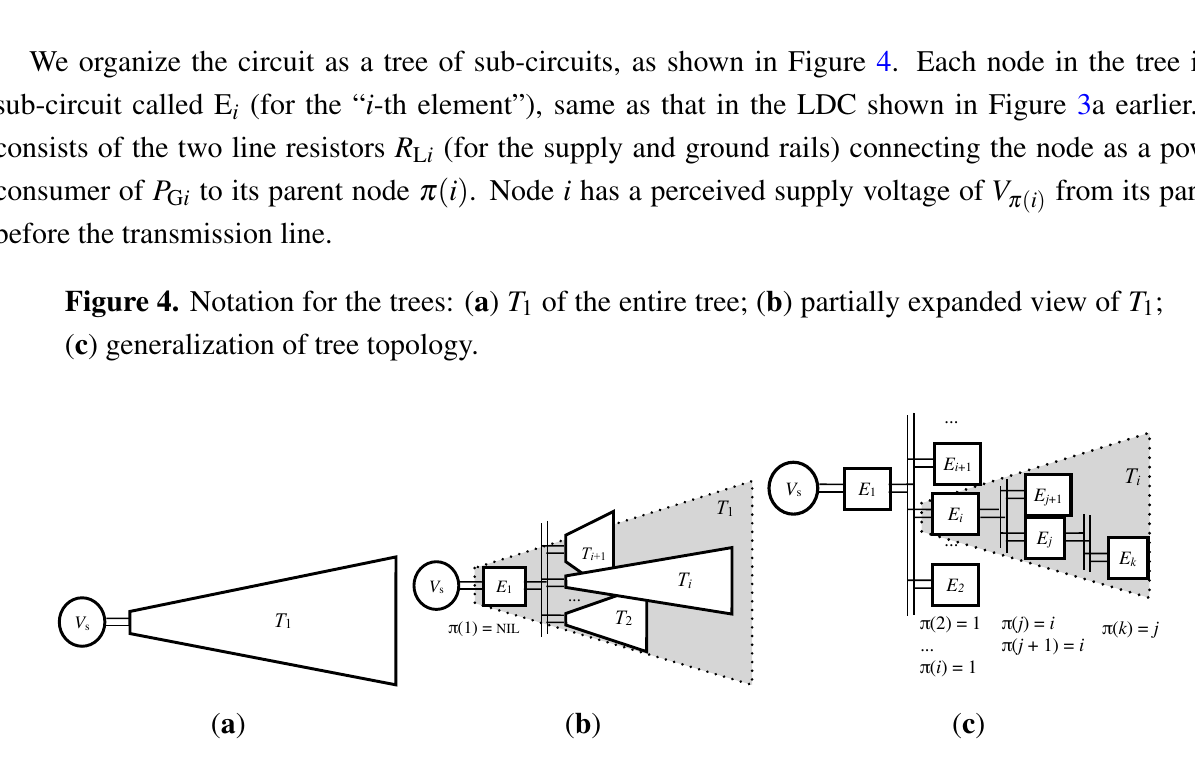
of the entire tree; ( b ) partially expanded view of T 1